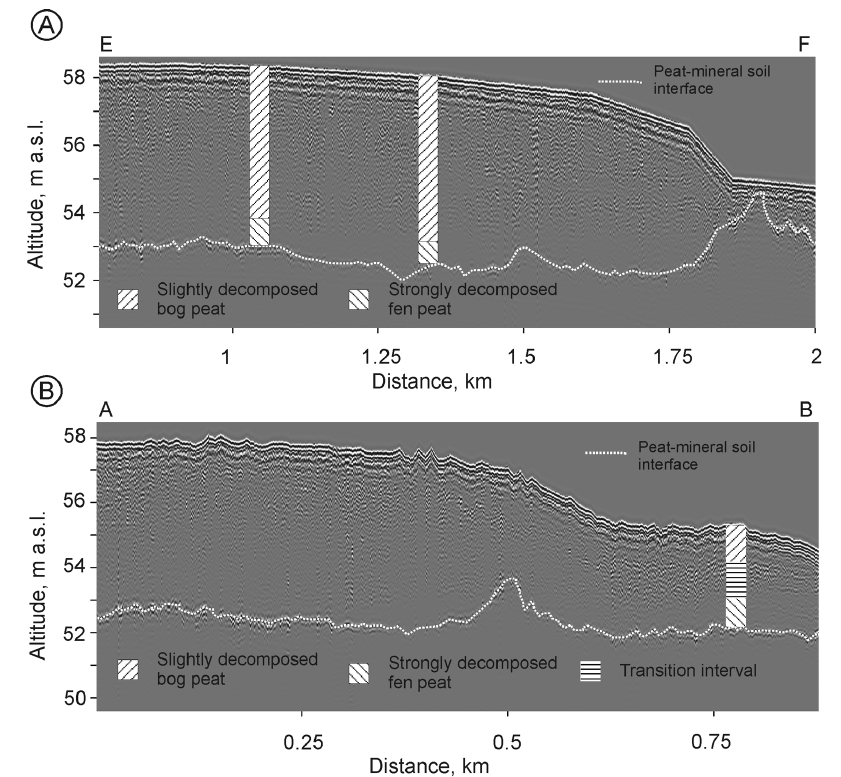
Fig. 4. Radar images of profiles AB and CD (for profile locations see Fig. 6). Bog peat is characterized by horizontally oriented and undulating reflectors while fen peat is lacking inner reflectors ( A ). Locally an interval of densely packed numerous sub- horizontal reflections with amplitude decreasing downwards marks the transitional zone between the two main types of peat ( B ). Note the different scales of the